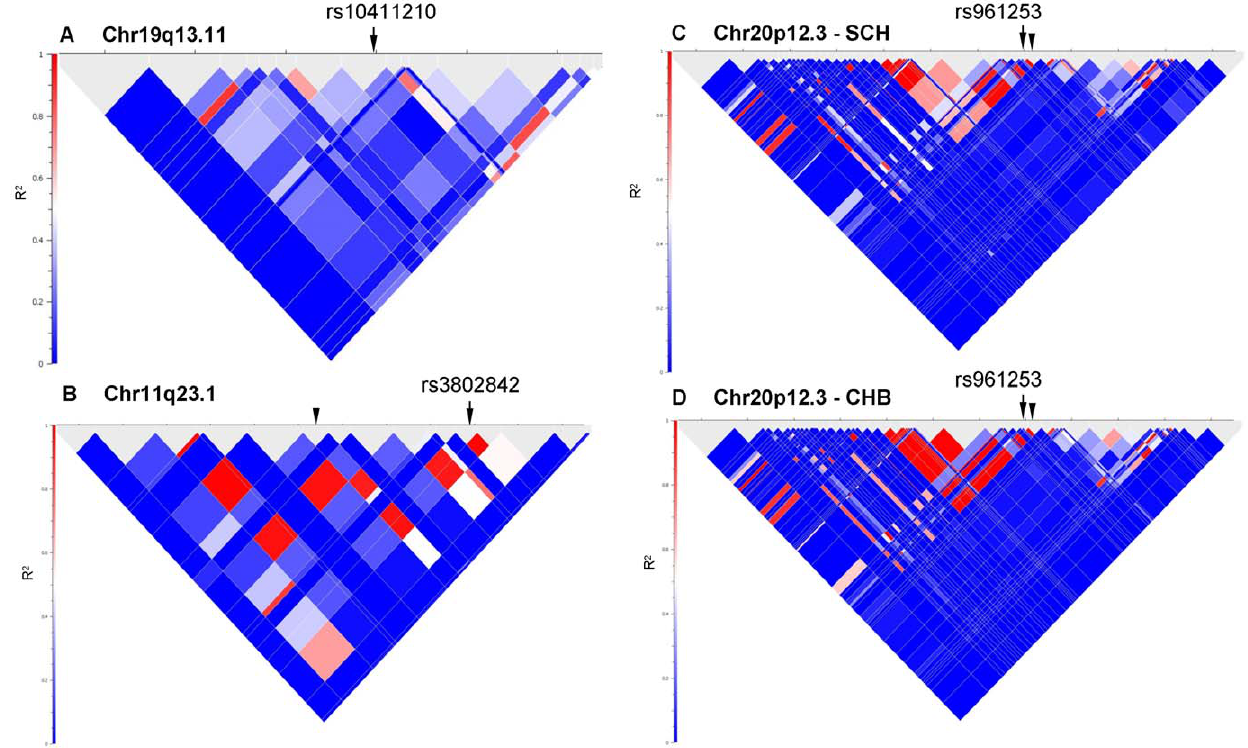
Figure 1. Local pairwise LD plots. The plots for SNPs at chromosomes 19q13.11 (A), 11q23.1 (B), 20p12.3 (C) and 20p12.3 (D) were derived from SCH controls and HapMap CHB individuals respectively. Arrow and arrowhead indicate positions of iSNP and sSNPs interrogated. The sSNPs interrogated at chromosomes 11q23.1 (B) and 20p12.3 (D) were rs3087967 and rs5005940 respectively. LD was measured as R 2 .